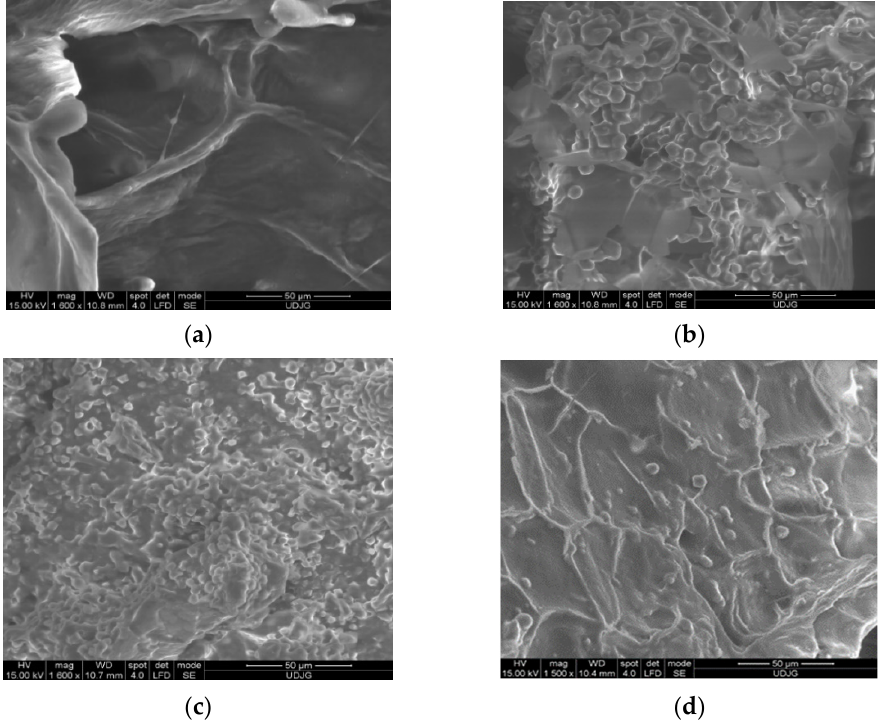
Figure 1. Structural and morphological characteristics of freeze-dried kiwi byproduct-based powders inoculated with Lacticaseibacillus casei 431 ® (freeze-dried samples based on: ( a ) kiwi pomace; ( b )—kiwi pomace and buckwheat flour; ( c ) kiwi pomace and black rice flour and ( d )—kiwi